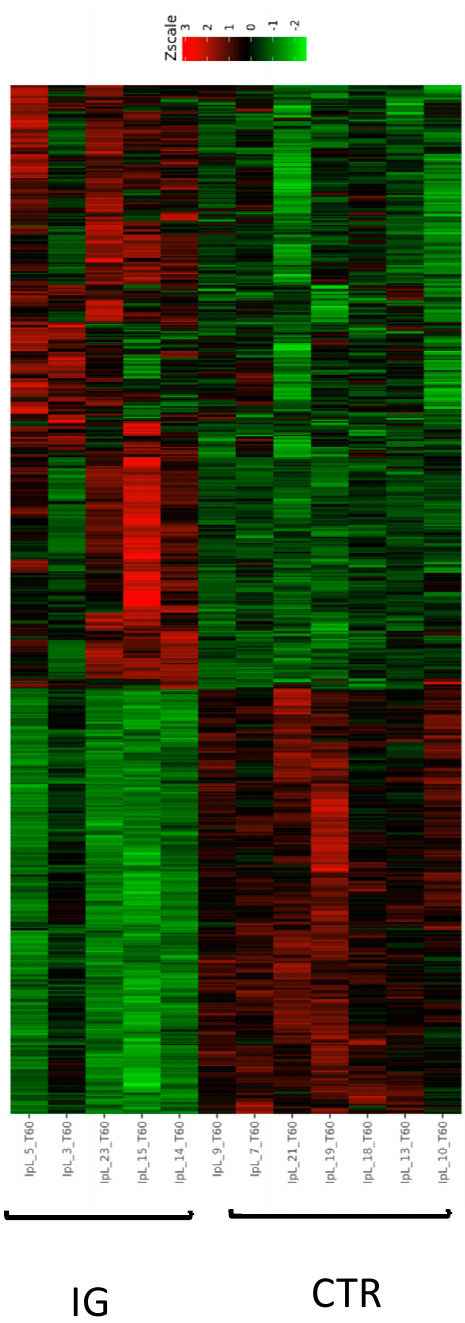
Figure 3. Heat map analysis of the 525 differentially expressed genes identified at the end of iodine supplementation period.